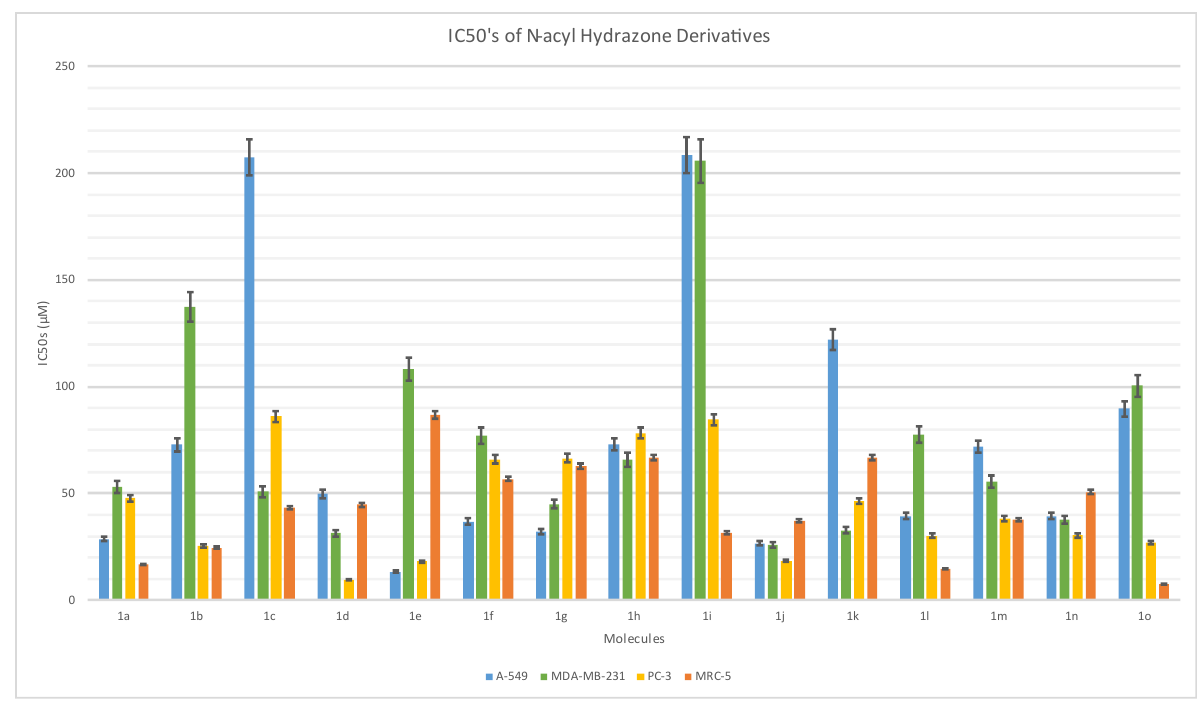
Figure 2. IC50 values of N-acyl hydrazones on A549, MDA-MB-231, and PC3 cell lines and MRC5 healthy human cells. Cells were treated with increasing dosages of (25–300 M) compounds. Control cells were treated with an equal amount of DMSO. Error bars show SEM.